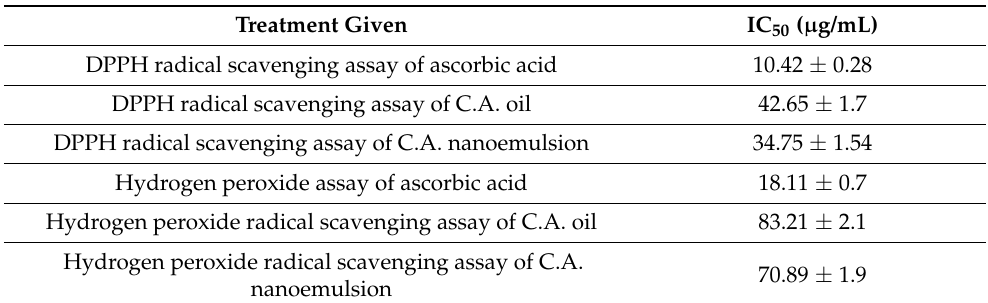
Table 2. Comparative IC 50 study of ascorbic acid CEO and CEO-NE via hydrogen peroxide and DPPH radical scavenging